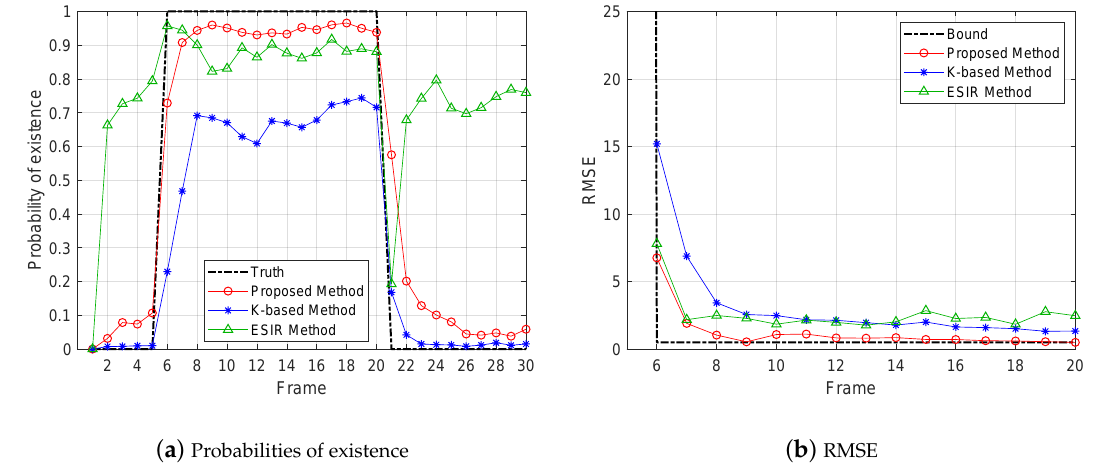
Figure 11. Probabilities of existence and Results of RMSE in case of SCR = 16 dB.